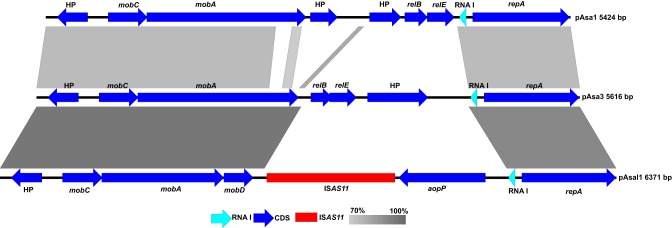
Maps of the ColE2-type replicon plasmids pAsa1, pAsa3, and pAsal1. The gray zones represent high identity regions of the sequences. The dark and light blue arrows represent coding sequences (CDSs) and the RNA I regulator, respectively. The red rectangle represents the ISAS11 of pAsal1. HP means “hypothetical protein.” The complete map of pAsal1 is given in Figure S1.